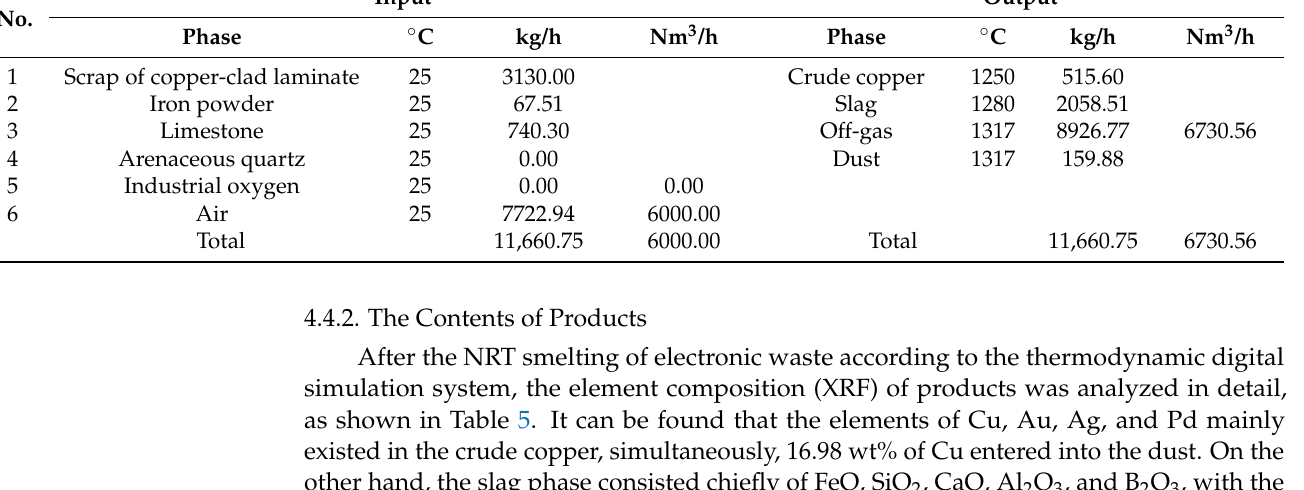
Table 4. The input – output material balance in the NRT smelting of electronic waste.